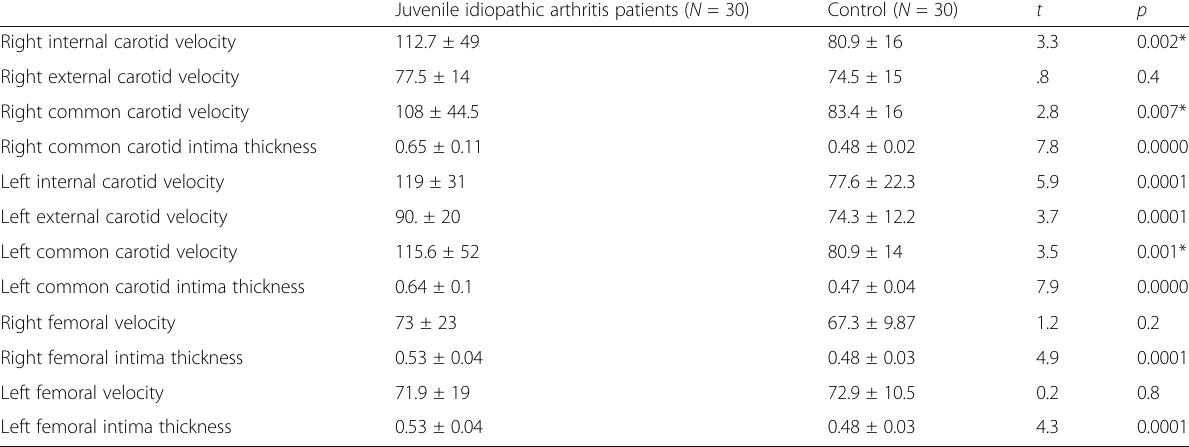
Table 2 Comparison between juvenile idiopathic arthritis patients and healthy controls as regards parameters of subclinical atherosclerosis by ultrasonography